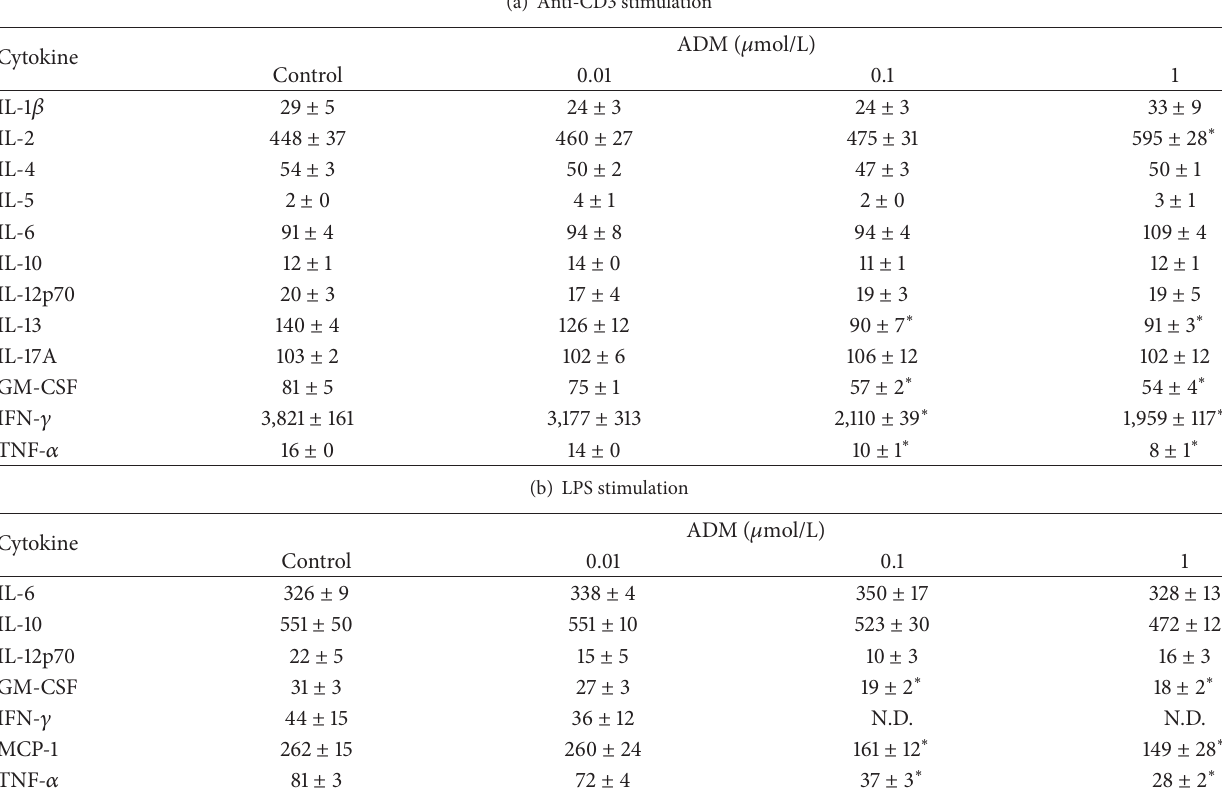
Table 2: Effects of adrenomedullin on cytokine induction due to anti-CD3 or LPS